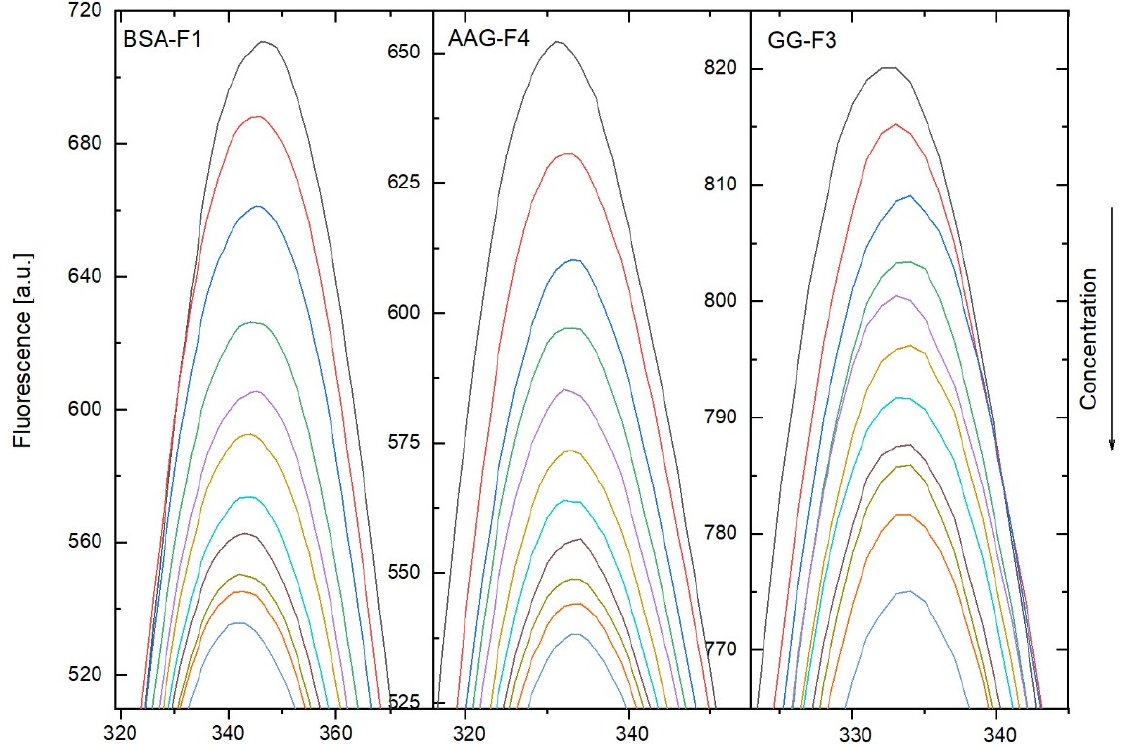
Figure 2. Fluorescence spectra (zoom on maximum) of BSA-F1, AAG-F4, and GG-F3 systems in the presence of compounds F1, F4, and F3. The concentrations were: 0, 0.2, 0.4, 0.6, 0.8, 1.0, 1.2, 1.4, 1.6, 1.8, and 2.0 µM.